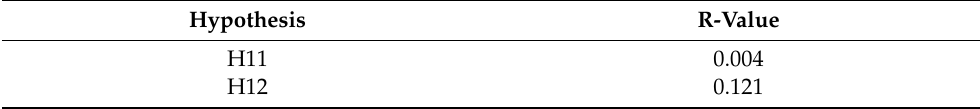
Table A4. Questions for the correlation of BMI with the level of physical